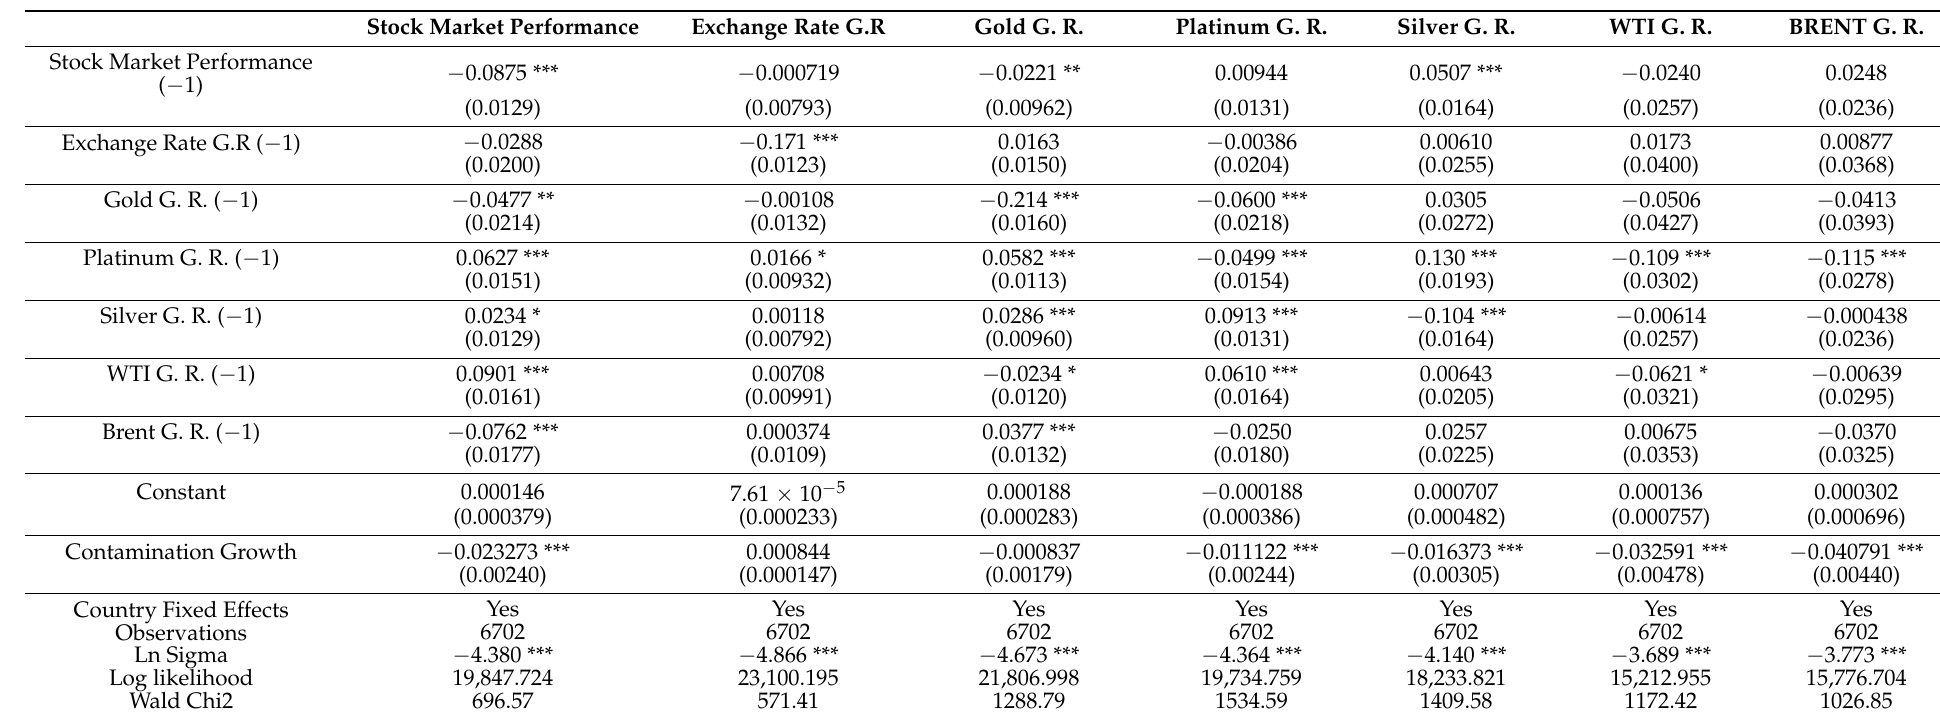
Table A4. Panel VAR Regression—Maximum Likelihood